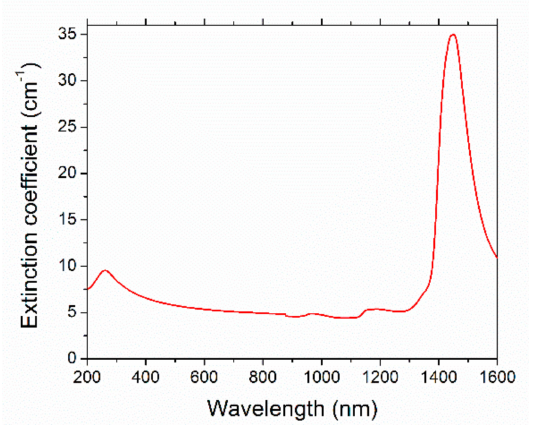
Figure 1. Spectral extinction coefficient of the sample with 0.13 g/L concentration. The experimental uncertainty on the extinction coefficient is 2%.